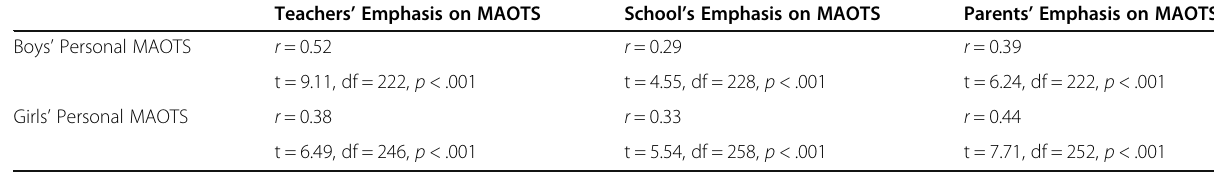
Table 3 Correlations between students ’ personal MAOTS and their perceptions of the environmental emphases on MAOTS